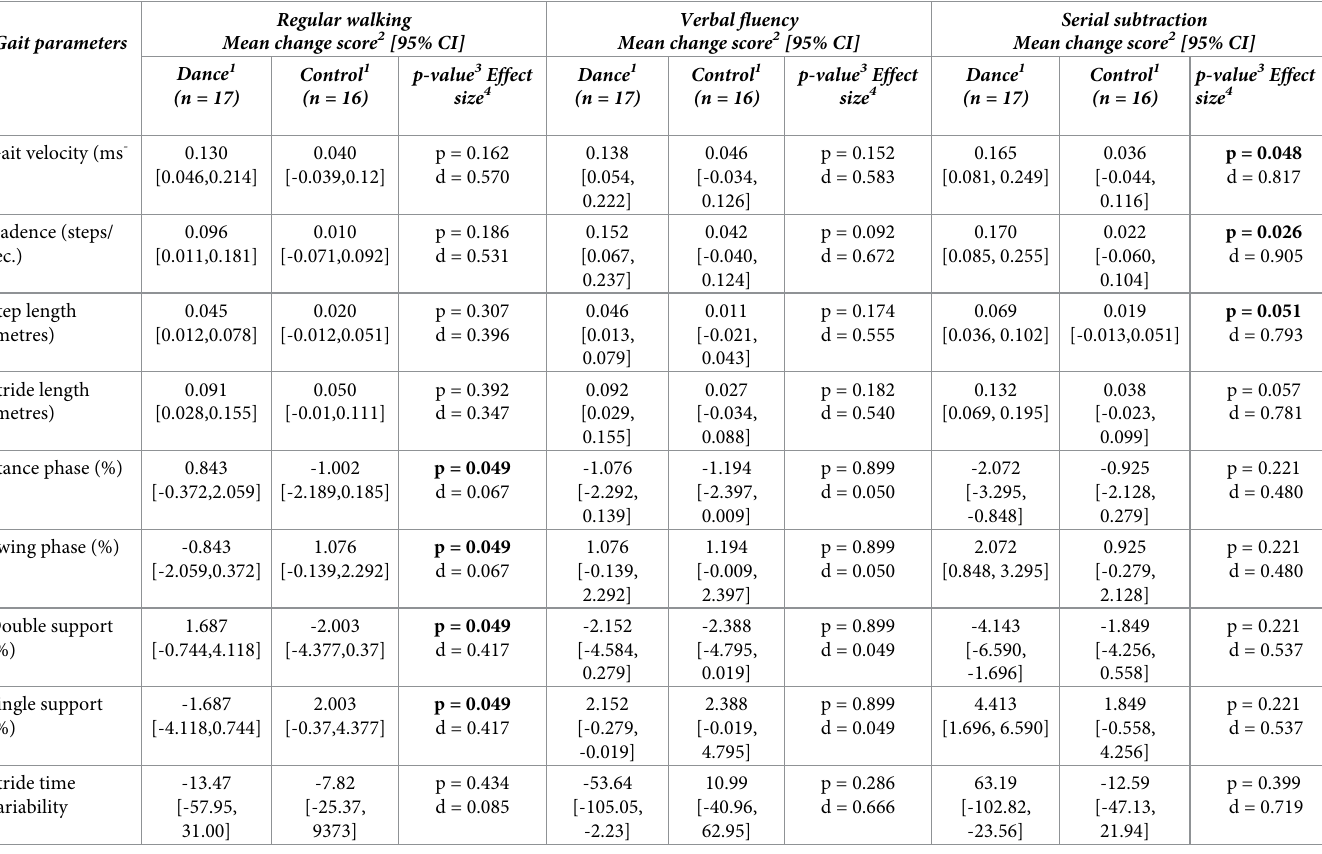
Table 5. Pre post change score of the spatiotemporal parameters of gait during uneven surface walking without a secondary task, and with cognitive secondary tasks. Gait